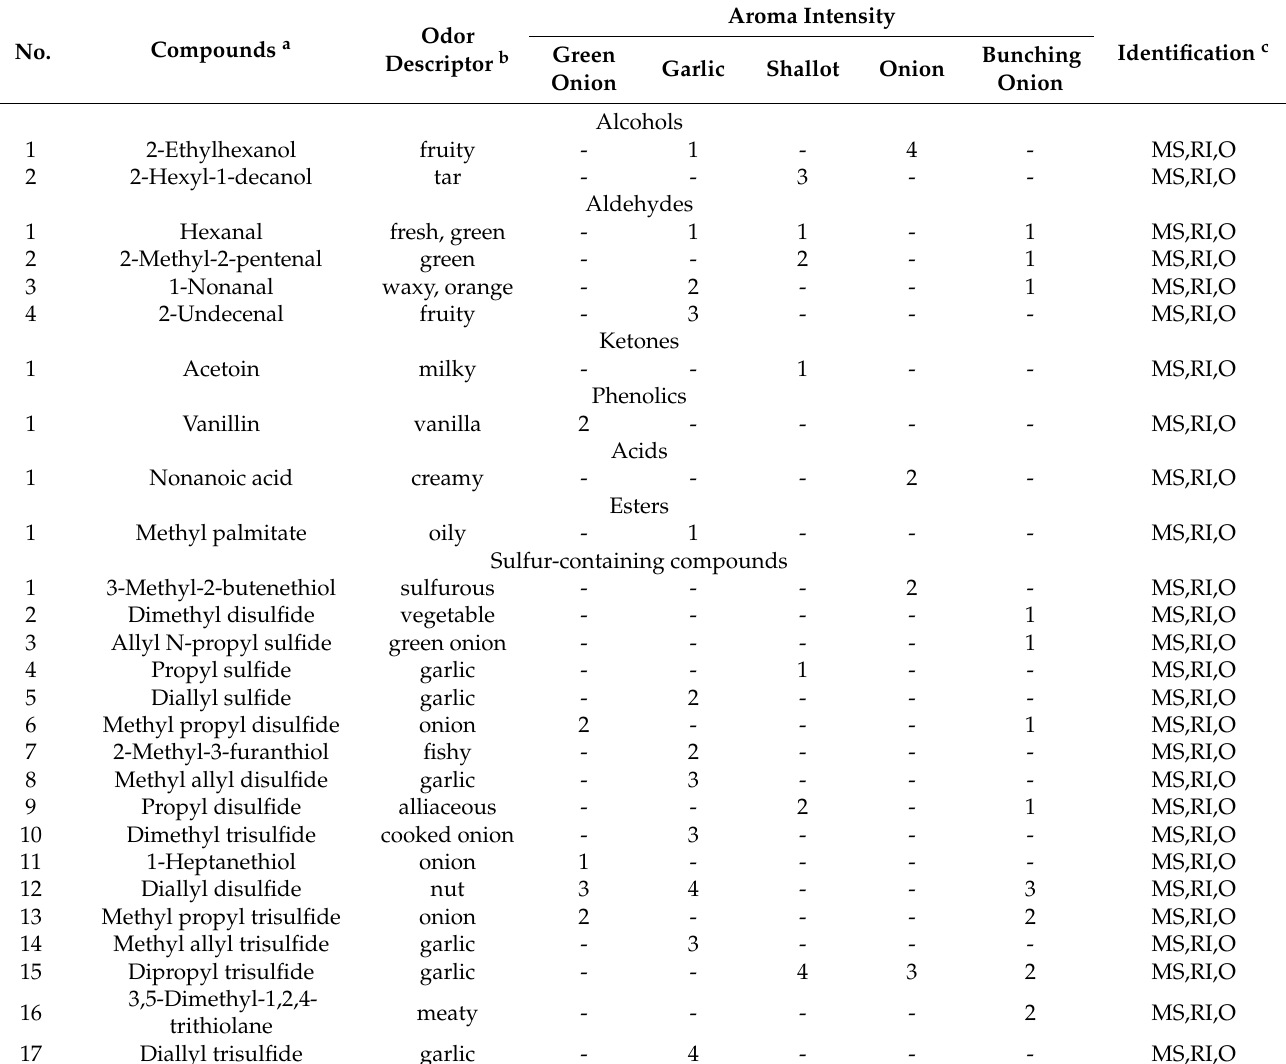
Table A1. Comparative analysis of the aroma active compounds detected in five fresh Allium plants by gas chromatography-olfactometry